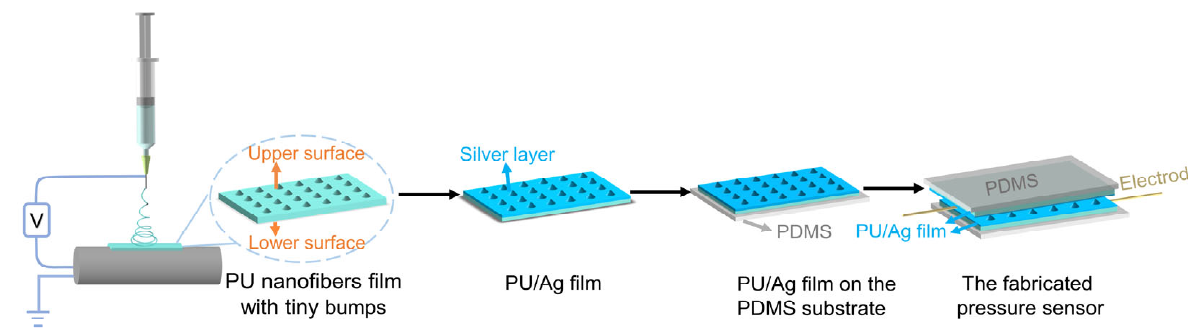
Figure 1. A schematic diagram of the fabrication process of the piezoresistive pressure sensor.